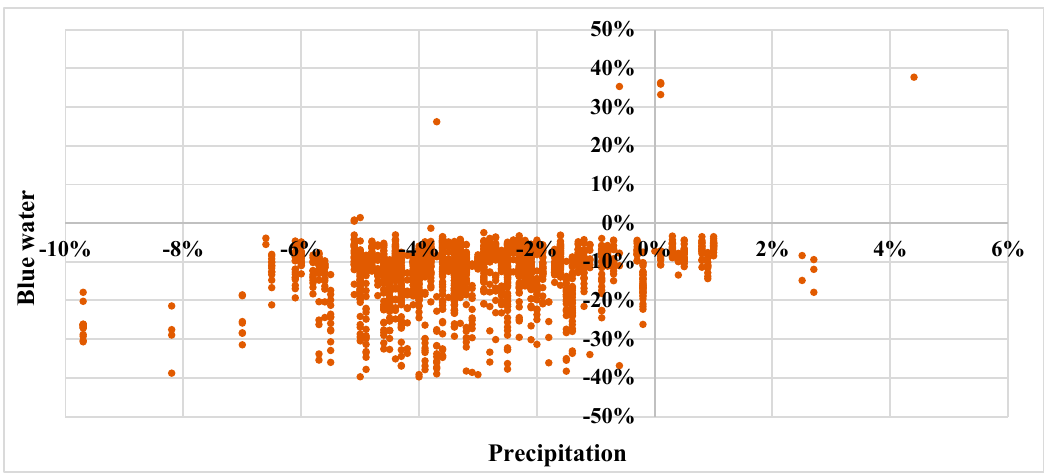
Figure 14. Change rates of precipitation and blue water in each sub-watershed under the median emission scenario (RCP4.5) relative to the baseline period.